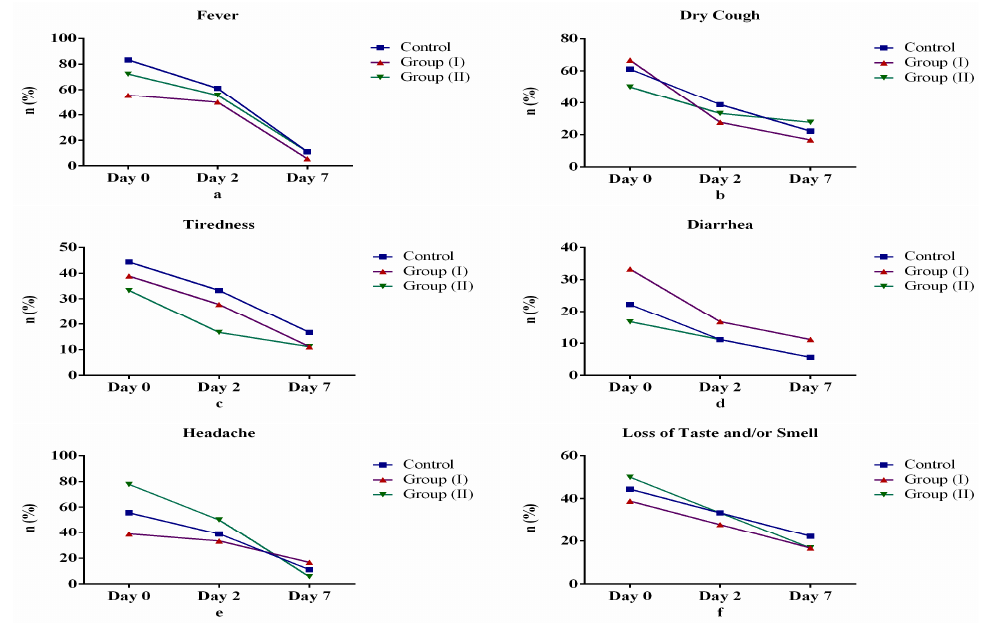
Figure 1. Comparison of clinical symptoms between control and treatment groups: ( a ) fever, ( b ) Dry cough, ( c ) tiredness, ( d ) diarrhea, ( e ) headache, ( f ) loss of sense of taste and/or smell.